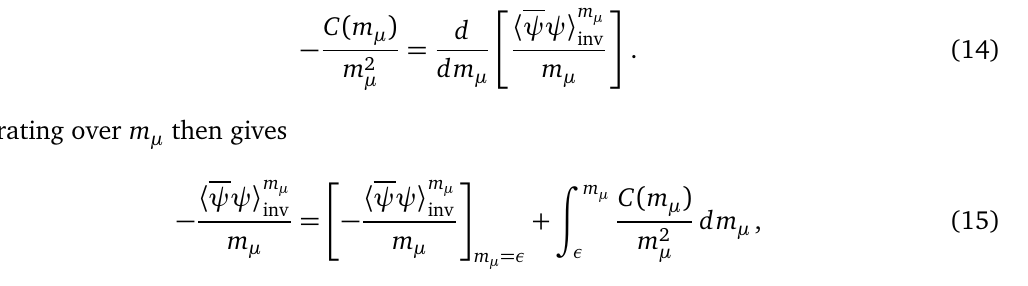
Figure 4: Absolute value of the condensate |〈 ψψ 〉 |〈 ψψ 〉 / m | (right) as a function of the fermion current mass m µ inv the color triplet representation. The blue and black lines show two different meth- ods to extract the condensate which are in reasonable agreement and show the the- oretical error involved. The solid(dashed) line shows regions where 〈 ψψ 〉 ( 〈 ψψ 〉 > 0 ) inv